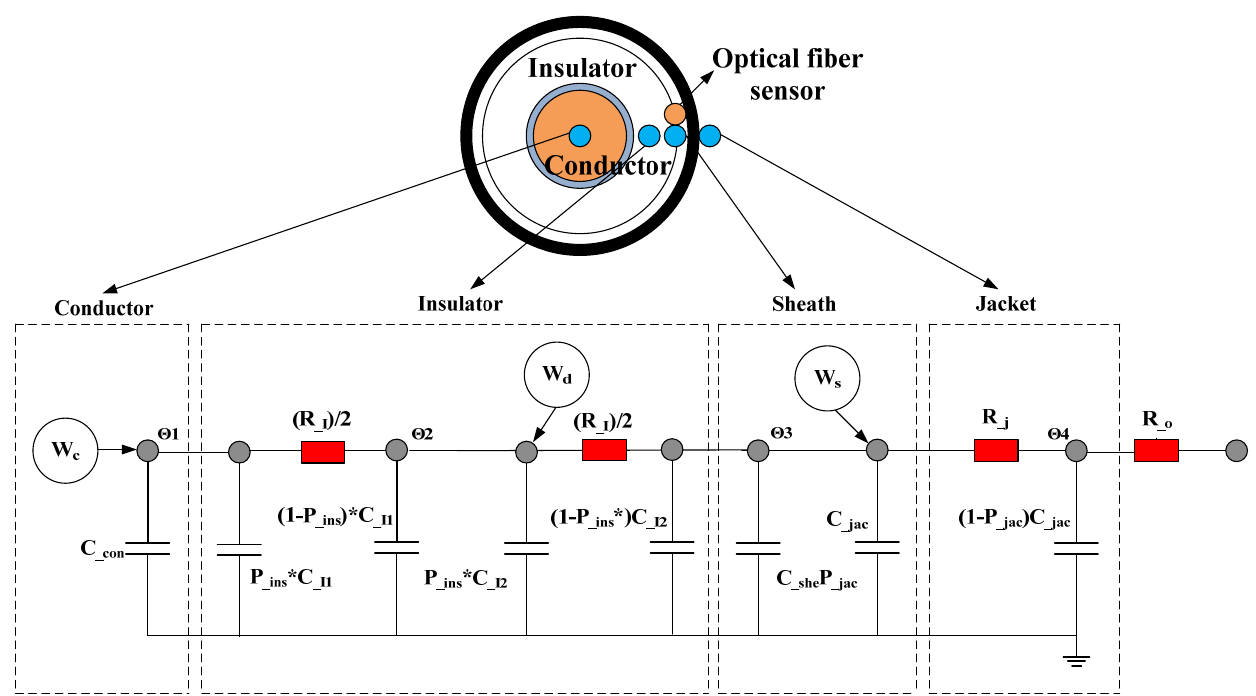
Figure 11. Cable thermal circuit